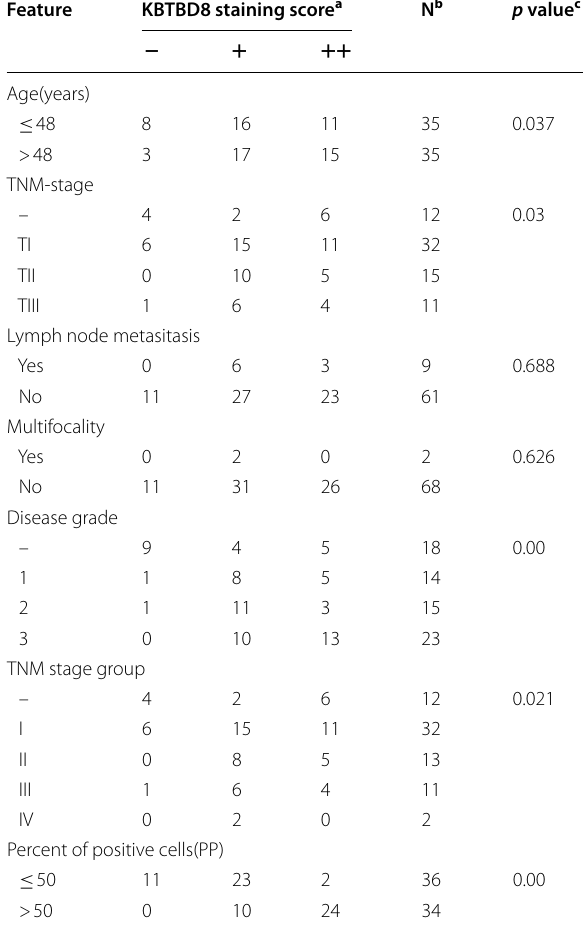
Table 1 Correlation and the malignance grade of the ovarian